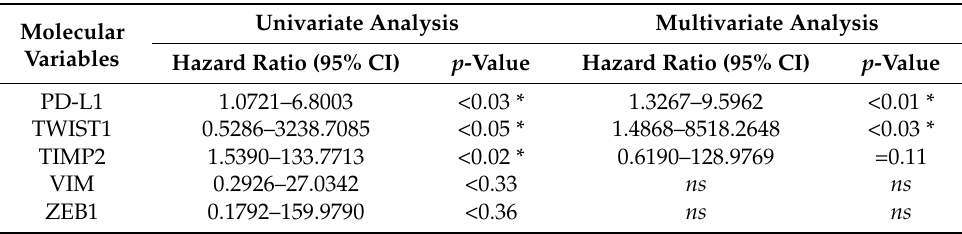
survival (RFS) in NMIB